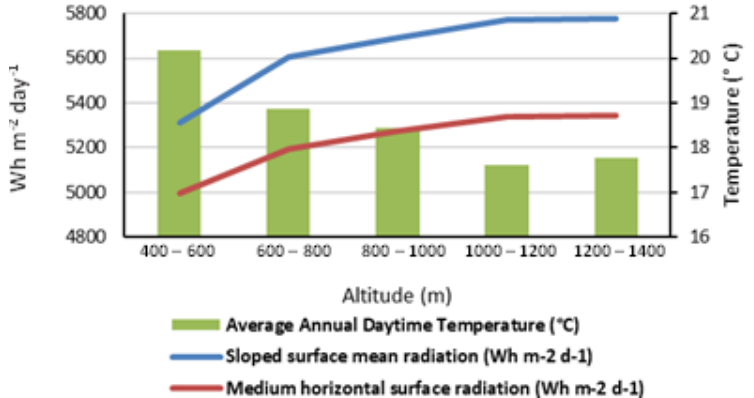
Figure 6. Solar potential by altitude. (GRAFCAN 2017-own elaboration).